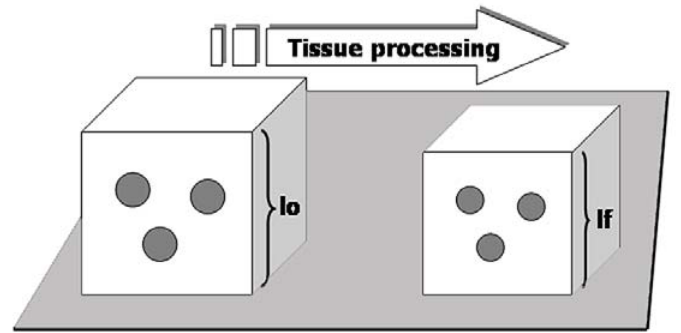
Fig. 3 –The shrunken tissue block (right side) occupies a smaller volume than the original fresh tissue volume (left side); lf and lo are some characteristic lengths in the shrunken and the original tissue block, respectively. The original volume (Vo) can be estimated from the shrunken volume (Vs): Vo = Vs . (lf/lo) 3 where If and lo are lengths in the shrunken and the original tissue block, respectively.